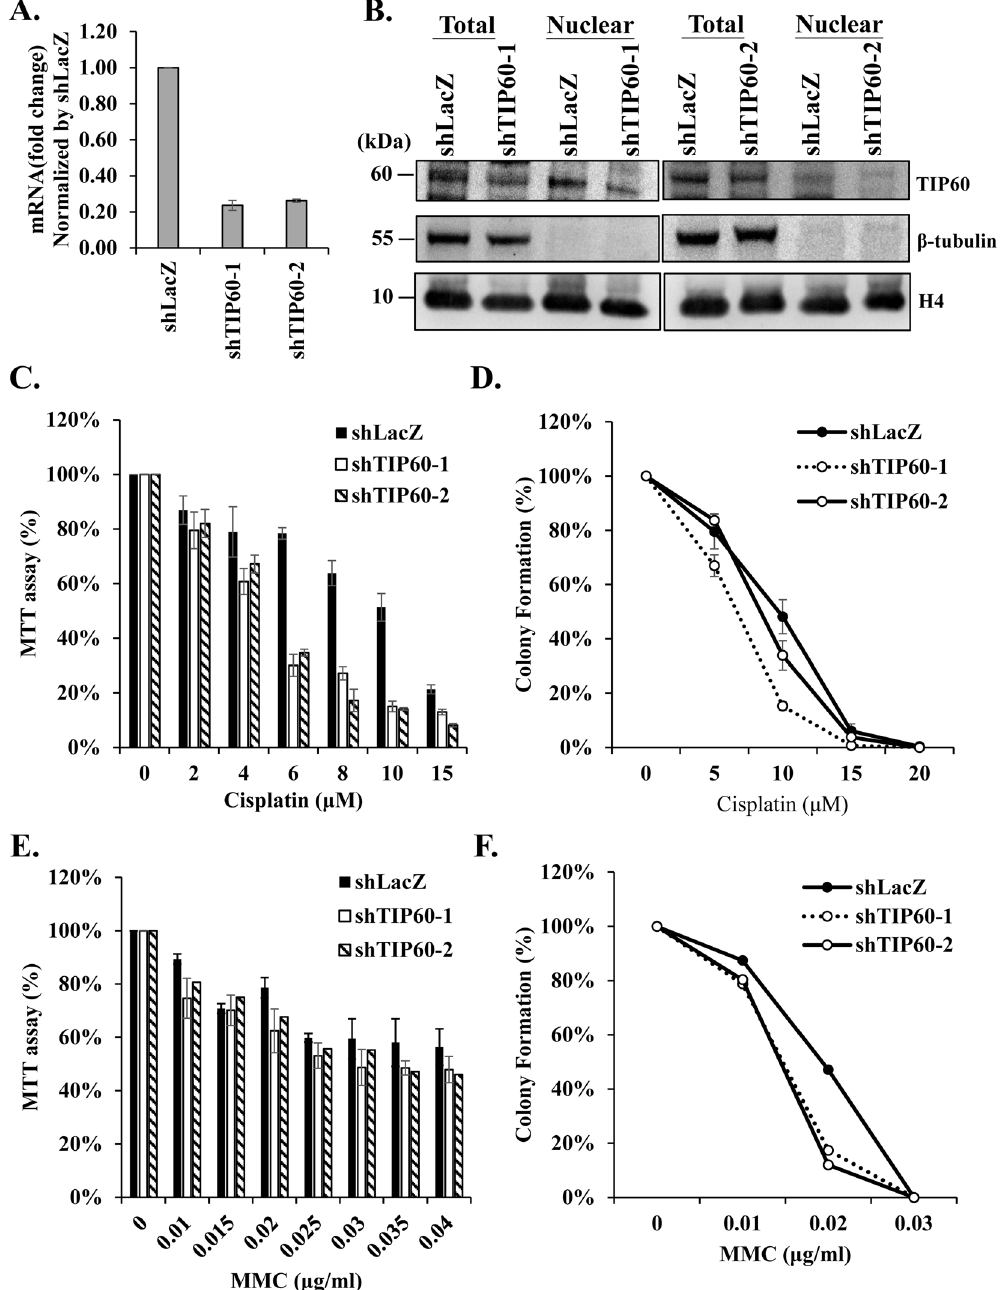
Figure 2. TIP60-deficient HONE6 cells are sensitive to cisplatin. ( A ) TIP60 was depleted by two specific shRNAs (shTIP60-1, and shTIP60-2) packed lentivirus in HONE6 cells. The shLacZ was used as a nontargeting control. The knockdown efficiency of TIP60 was determined by qRT-PCR and normalized by the level in the control cells. Each value represents the mean ± standard deviation from at least three experiments. ( B ) Cell lysates were subjected to Western blotting with an anti-TIP60 antibody. The total cell lysates and the nuclear fraction of cells were indicated. Full-length blot is presented in Supplementary Figure S5. ( C and E ) Cytotoxicity assay of TIP60-deficient cells. Cells were treated with various concentrations of cisplatin or MMC for 96 hours. Cytotoxicity was determined by MTT assay, with relative viability being normalized to colonies of no treatment control cells of each cell line. ( D and F ) The colony formation assay. Cells were chronically treated with cisplatin or MMC as indicated and incubated for 10 days. The resulting colonies were stained with 1% crystal violet. Relative viability was normalized to colonies of no treatment control cells of each cell line. Each value derived from the MTT assay and the colony formation assay represents the mean ± standard deviation from at least three